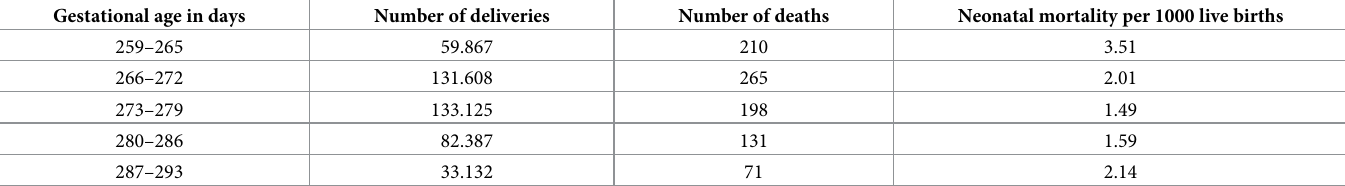
Table 2. Neonatal mortality rate according to gestational age at birth in days, municipality of S ã o Paulo, Brazil,